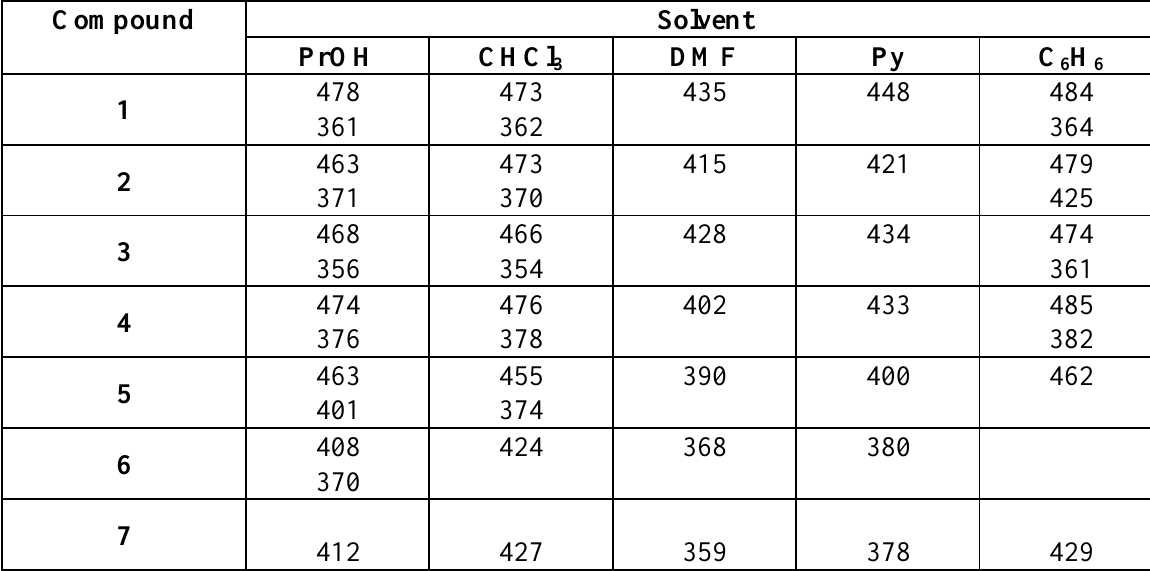
Table 2. Electronic spectra absorption band positions of dipyrromethenes and their analoges